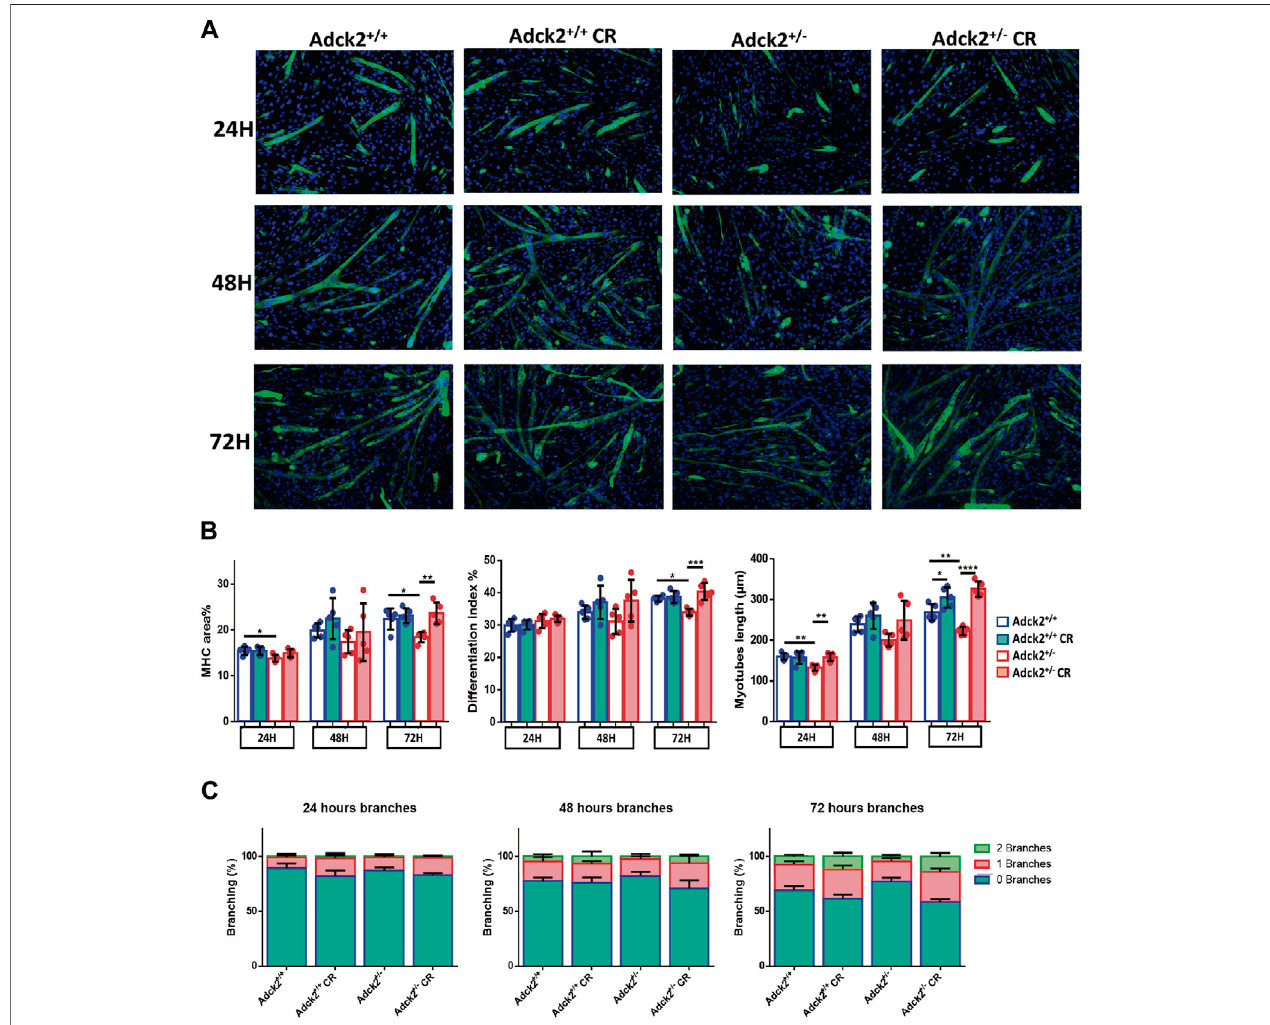
FIGURE 6 | Differentiation process of satellite cells analysis under calorie restriction conditions. Development of an in vitro model of CR using satellite cells isolated from mice. (A) . Representative images of satellite cell differentiation at 24 h, at 48 h and at 72 h post-induction. (B) Myosin heavy chain (MHC) area, differentiation index and myotube length. (C) . Branching capacity during the 72 h analyzed. DAPI was used to stain the nuclei of the myotubes in blue while differentiated myotubes were stained with MHC antibody in green. The differentiation process is determined by the increase of myotube size and the MHC expression level. Differentiation of satellite cells to myotubes is induced by a reduction in serum concentration. Fresh medium was replaced in each well every 48 h. CR, calorie restriction. Data represent the mean ± SD. One-way ANOVA test was applied. * p < 0.05; ** p < 0.01; *** p < 0.001; **** p < 0.0001.